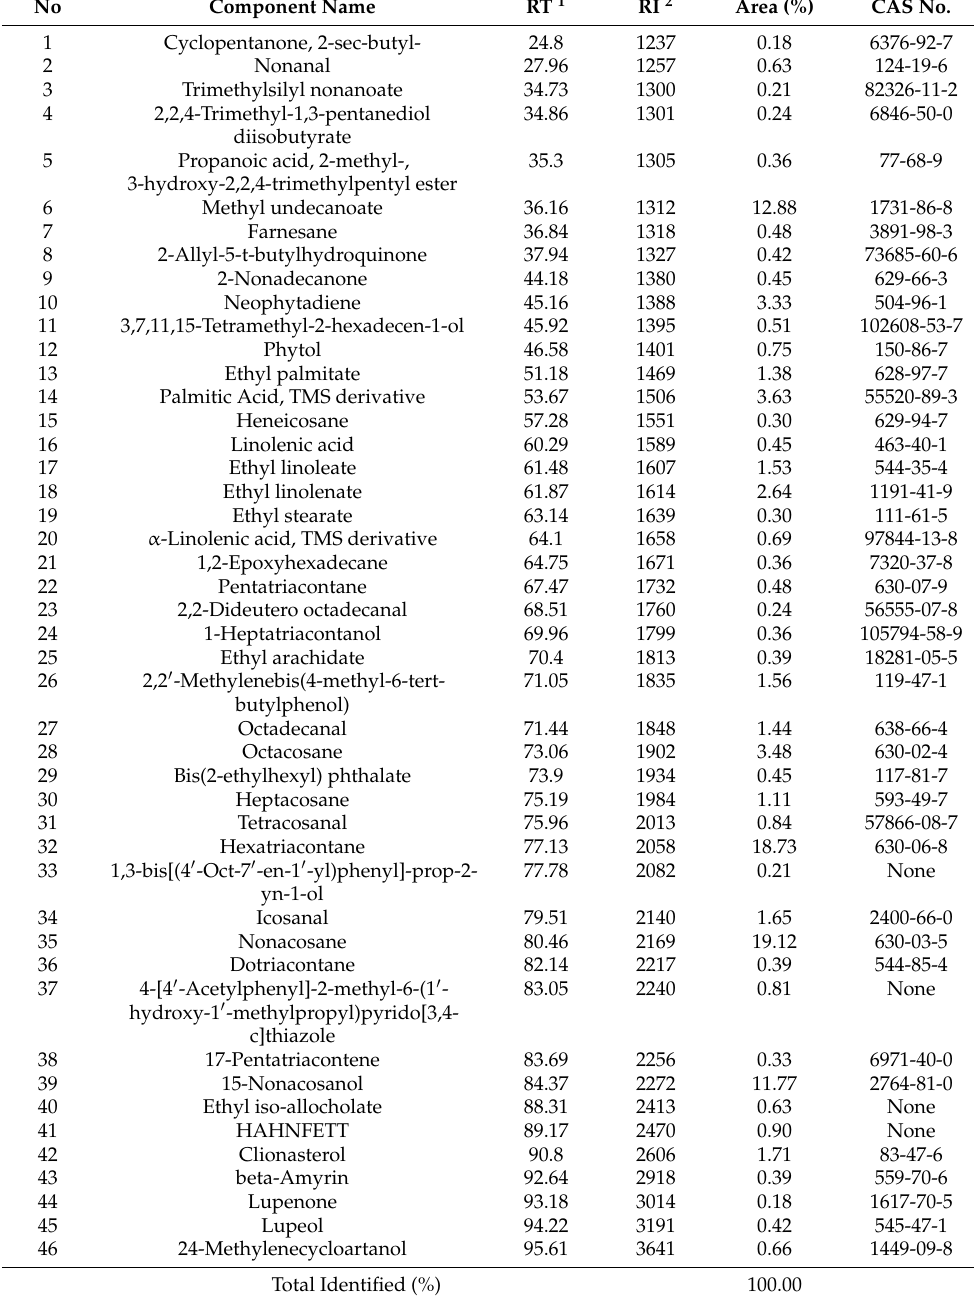
Table 1. Components of the absolute of Caragana sinica